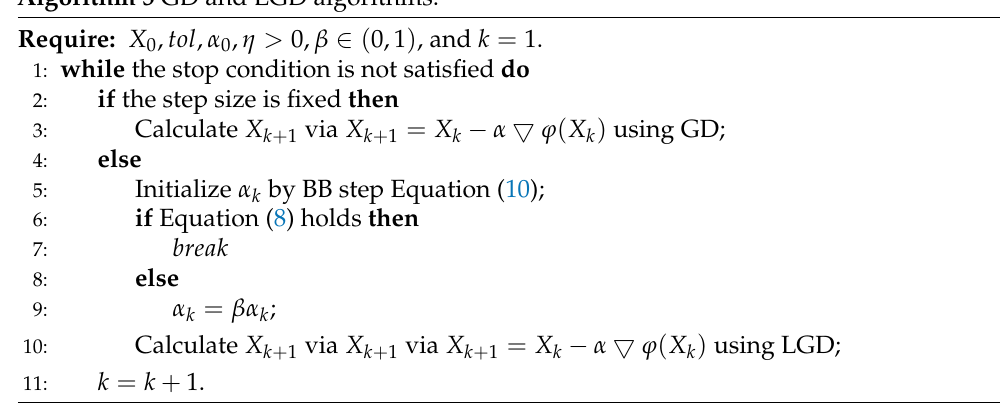
Algorithm 5 GD and LGD